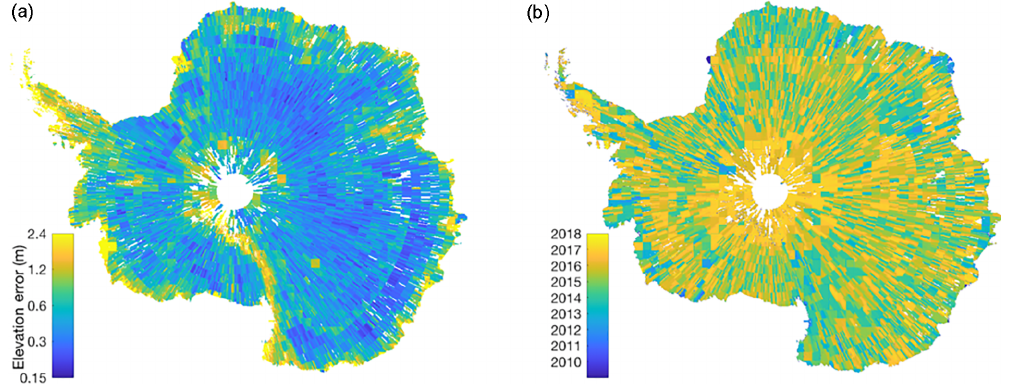
Figure 4. Maps of REMA (a) elevation error, obtained from the root mean square of the differences in elevation between the DEM and altimetry data following registration, or the differences among co-registered DEMs in the case of alignment (note the logarithmic color scale), and (b) date stamp obtained from the date of image